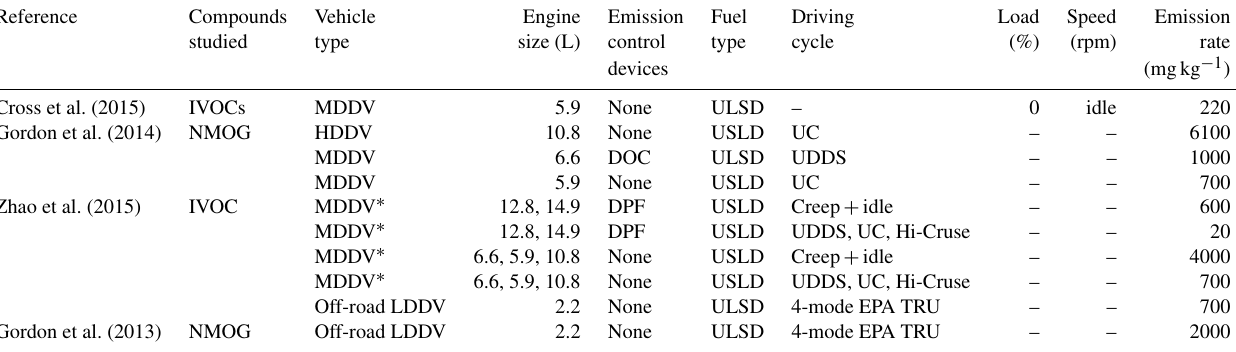
Table 3. Literature emission rates (expressed as mass emitted per kg of fuel burnt) from diesel exhaust emissions using different vehicle types and engine